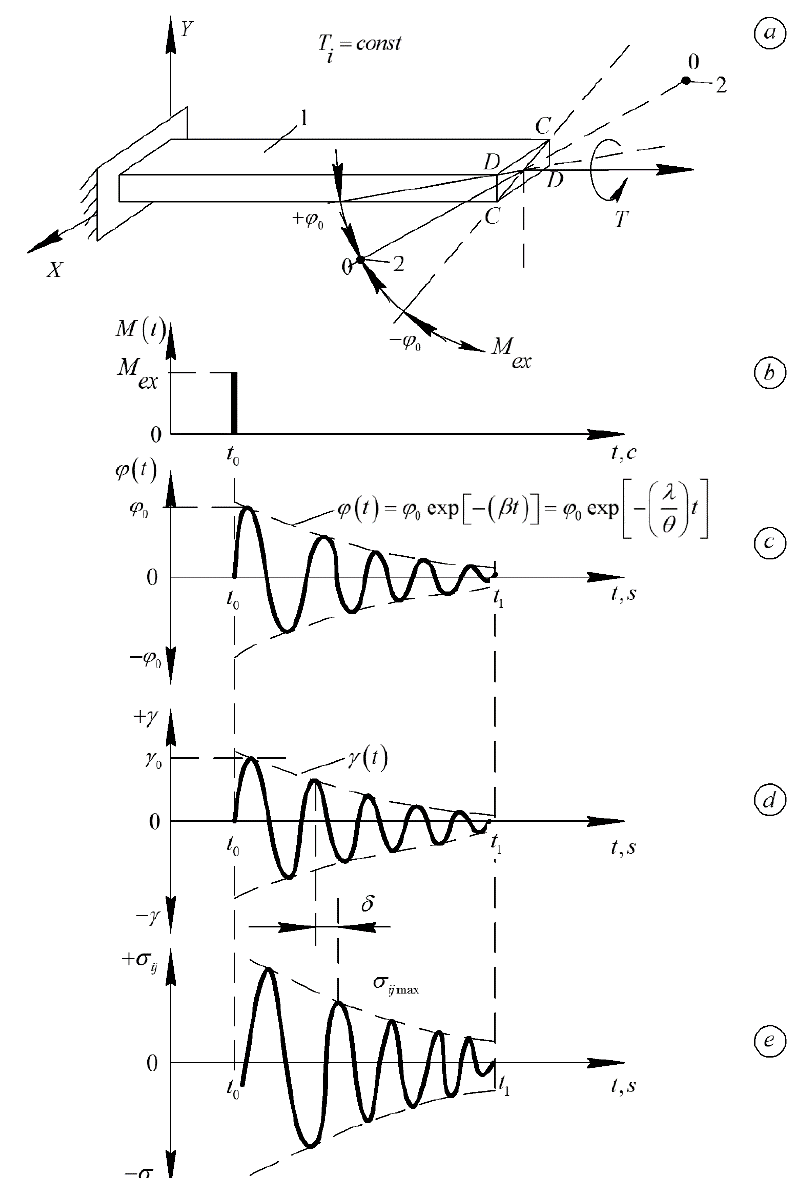
Figure 2. Diagrams of freely damped oscillatory process excited in the studied sample; ( a ) in isothermal mode T = const ; ( b ) by pulse action. Sweep of the time dependence of the twist angle ϕ ( t ) relative to the longitudinal axis Z of the specimen ( c ). The deformation of the sample— γ ( t ) ( d ) and the corresponding shear stresses σ ij occurring in the sample ( e ). β —damping coefficient of the oscillatory process; θ —period of the vibration process. All other designations are defined below in the text of the